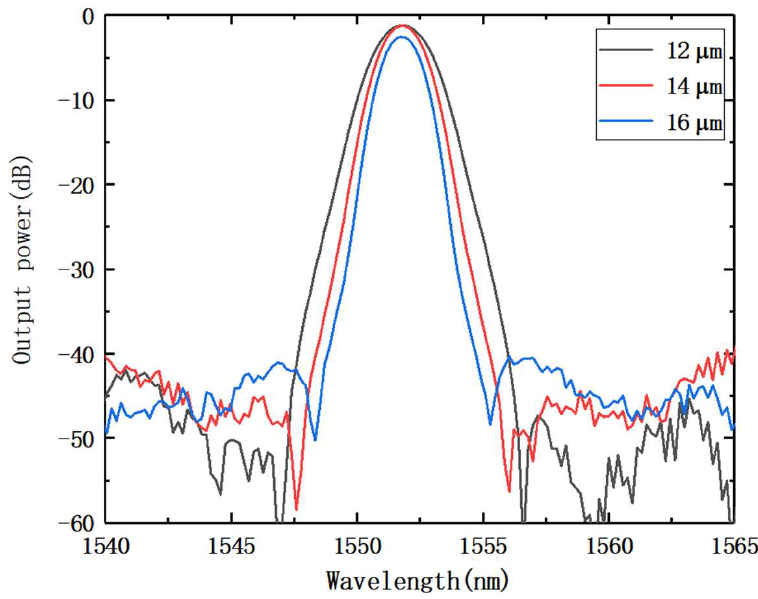
Figure 3. Transmission spectra under different adjacent output waveguide distance.